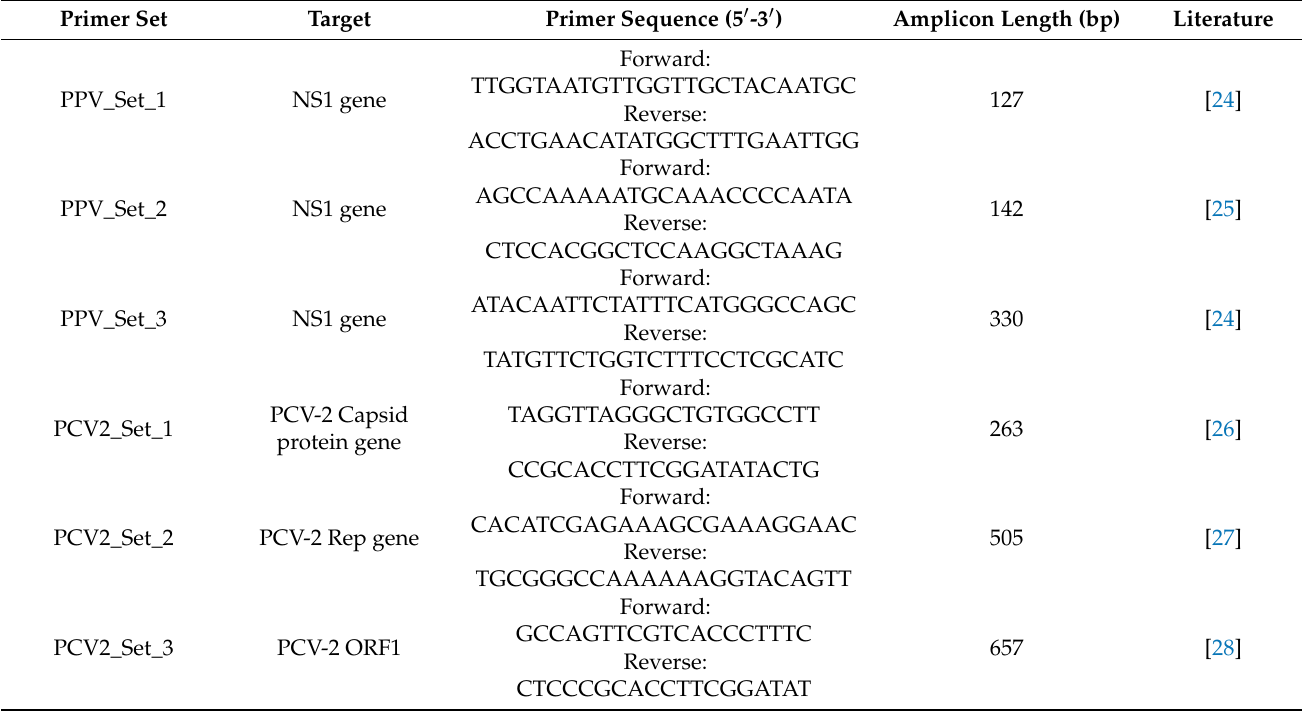
Table 1. Primer sets used in conventional PCR for PPV and PCV-2 detection.